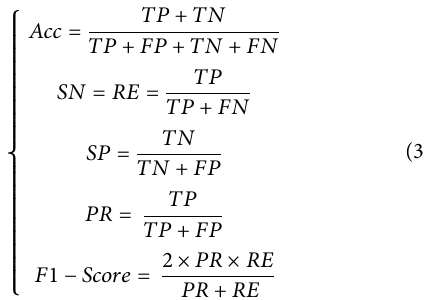
FIGURE 3 The details of the Swin Transformer